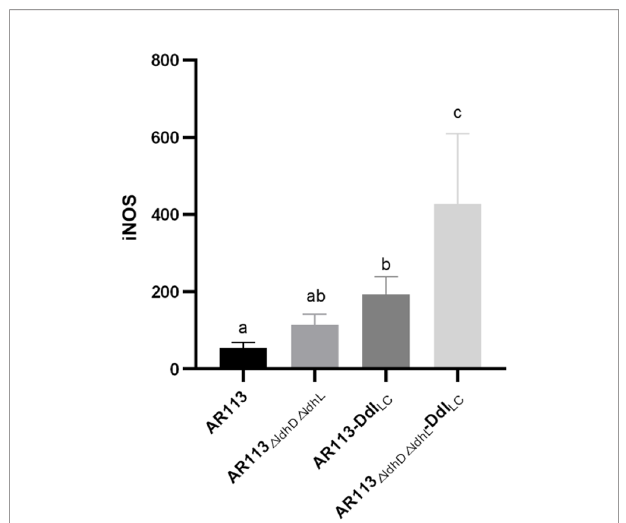
FIGURE 2 | Effect of Ddl-overexpressing L. plantarum strains on iNOS production in macrophages. The statistical analyses were assessed using one-way ANOVA. Data are represented as means ± standard deviations (n = 7). Data indicated with different letters differ signi fi cantly (P < 0.05).